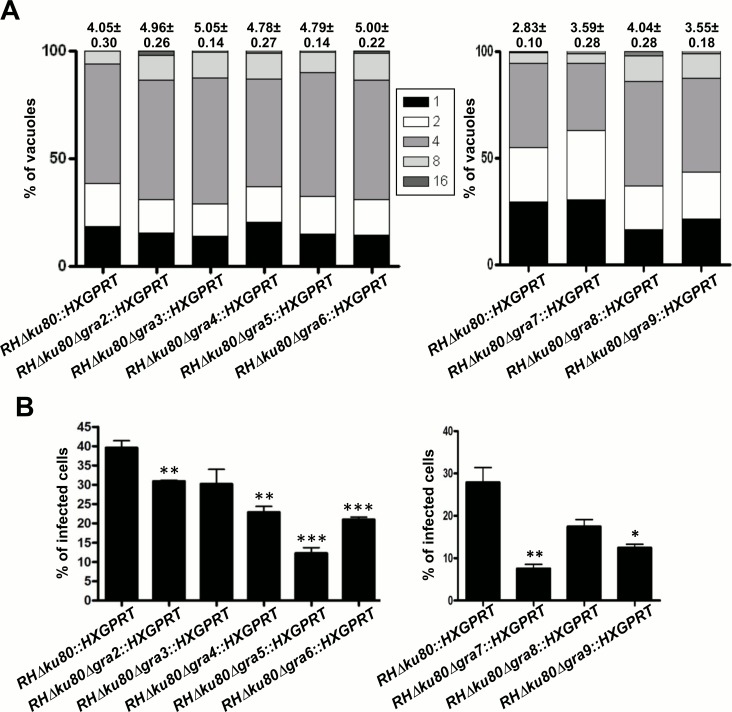
Replication and infection rates of single Δgra2-9 gene knockout strains calculated by high throughput microscopy.A) Replication rate of each of the Δgra2-9 strains compared to that of the parental strain. The percentage of PVs containing 1, 2, 4, 8 or 16 parasites per vacuole was calculated from three coverslips of infected HFFs. The numbers above each bar represent the average number of parasites per vacuole calculated from the total number obtained the three coverslips. The values are representative of one experiment out of three, which provided similar results. B) Percentage of HFFs infected by each Δgra2-9 knockout strain versus the parental Δku80 strain. The infection rate was calculated from the number of PVs observed on three coverslips. Comparisons between the parental strain and each of the knockout strains were performed using a Student’s t-test and asterisks indicate significant differences. *: p = 0.0128 for Δgra9; **: p = 0.0099 for Δgra2, 0.0022 for Δgra4, 0.0051 for Δgra7; ***: p = 0.0003 for Δgra5 and 0.0007 for Δgra6. The values are representative of one experiment out of three, which provided similar results. The total number of PVs observed in A and B are respectively: parental Δku80 strain, 5,757 (left panel) and 5,206 (right panel); Δgra2, 5,200; Δgra3, 5,173; Δgra4, 6,176; Δgra5, 5,845; Δgra6, 6,311; Δgra7, 5,165; Δgra8, 5,177; Δgra9, 5,065.